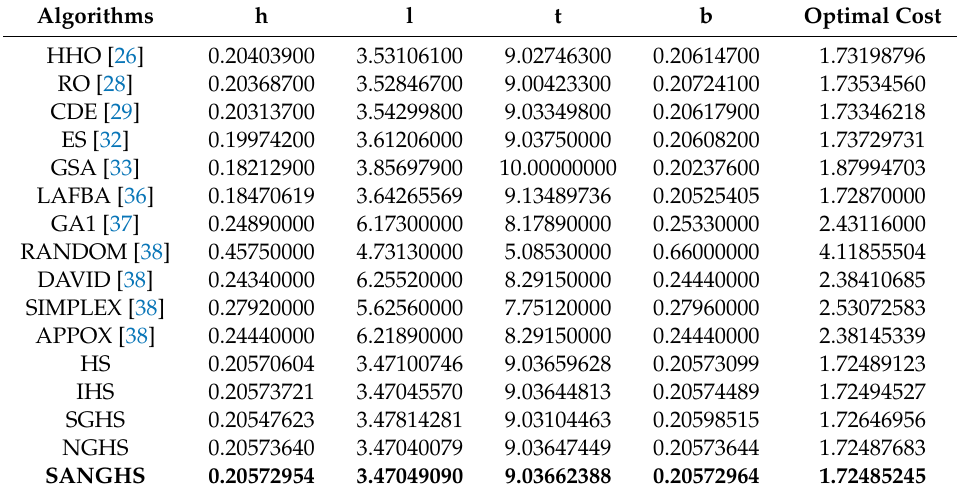
Table 9. Experimental results in the welded beam design engineering